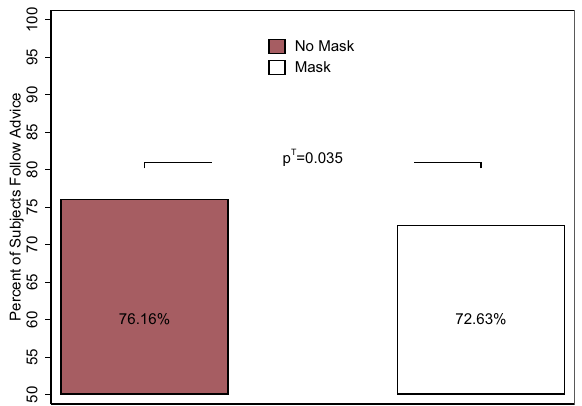
Figure 2. Following advice. Notes : The bar in red depicts the unconditional mean in the control (no mask) condition ( N = 906 ), and the bar in white depicts the mean in the treatment (mask) condition ( N = 961 ). The p T -value represents the p -value for the treatment effect. Standard errors are clustered at the state level. Conditional estimates controlling for state fixed effects, week fixed effects, design controls, and individual groups are presented in Table S4.